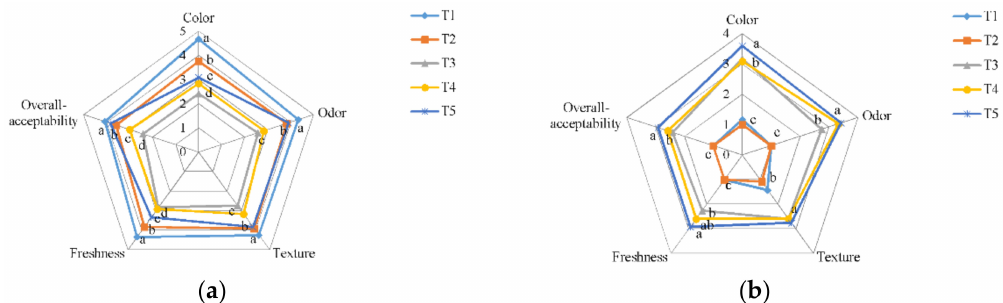
Figure 3. Sensory properties of chicken meat coated with chitosan containing AFEOs at day 0 ( a ) and day 9 ( b ) during storage at 4 ◦ C. T1: Negative control; T2: Distilled water; T3: 1% CH coating + 500 ppm AFEOs; T4: 1% CH coating + 1000 ppm AFEOs; T5: 1% CH coating + 1500 ppm AFEOs. a–d Mean values among meat samples not followed by a common letter differ significantly ( p <